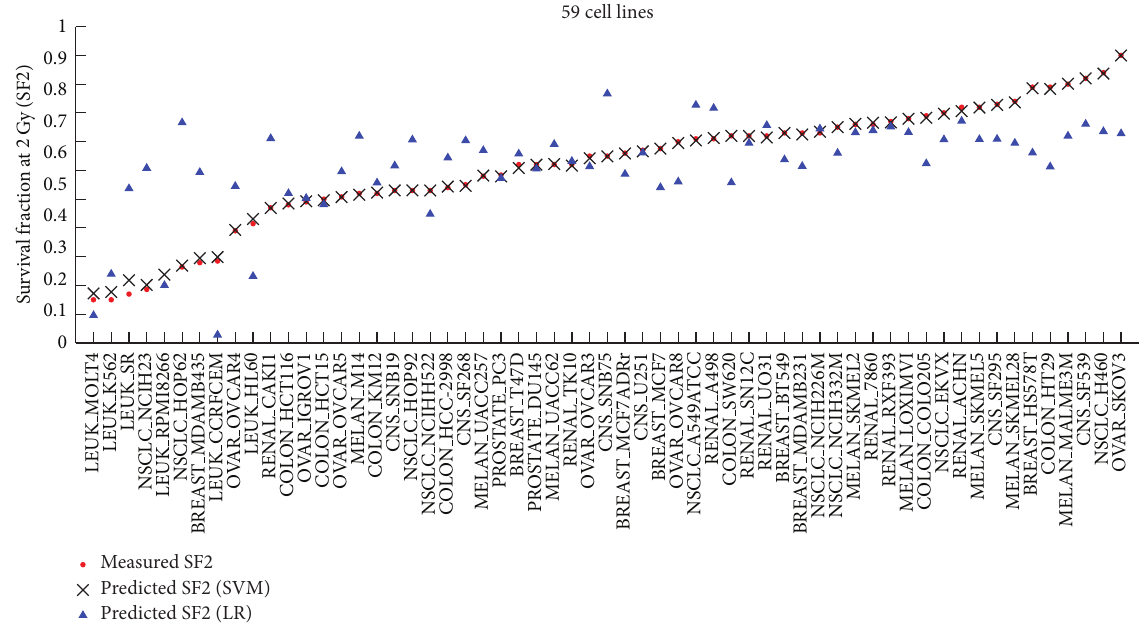
Figure 3: Comparisons between SVM regression and line regression (LR)